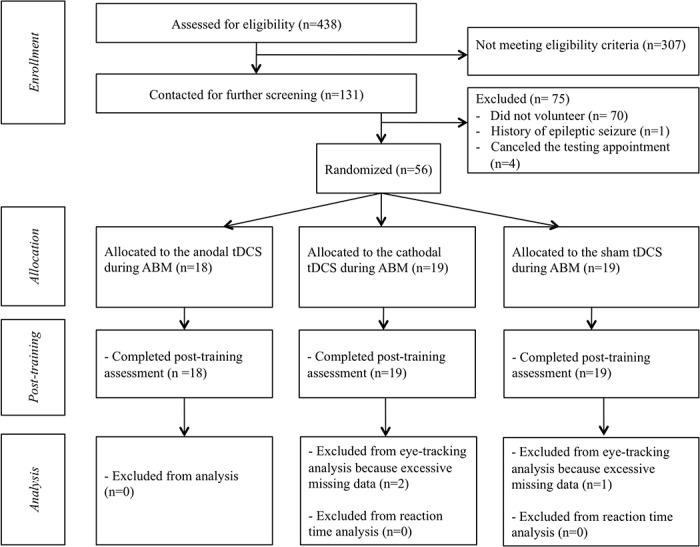
Flowchart depicting passage of participants through the study.ABM is for Attention Bias Modification; tDCS is for transcranial Direct Current Stimulation.